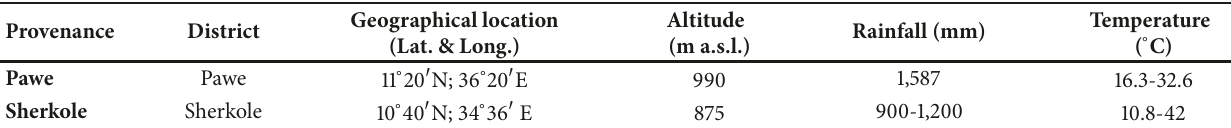
Table 1: Geographic locations and climatic conditions of O. abyssinica seed provenances at Benishangul-Gumuz Regional State, western